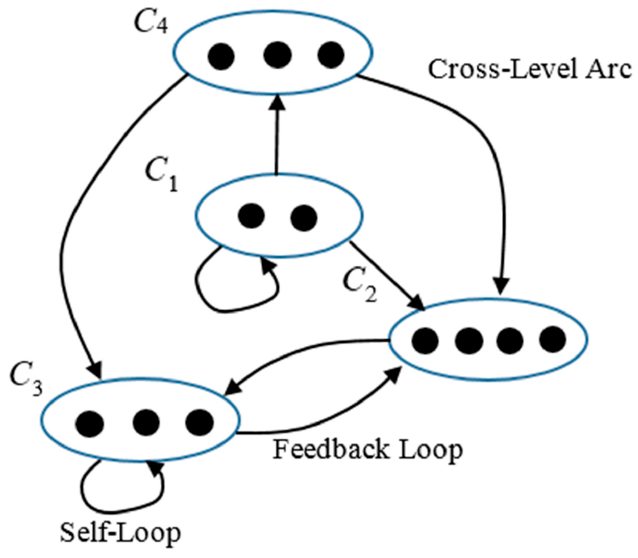
Figure 5. A general ANP network structure.